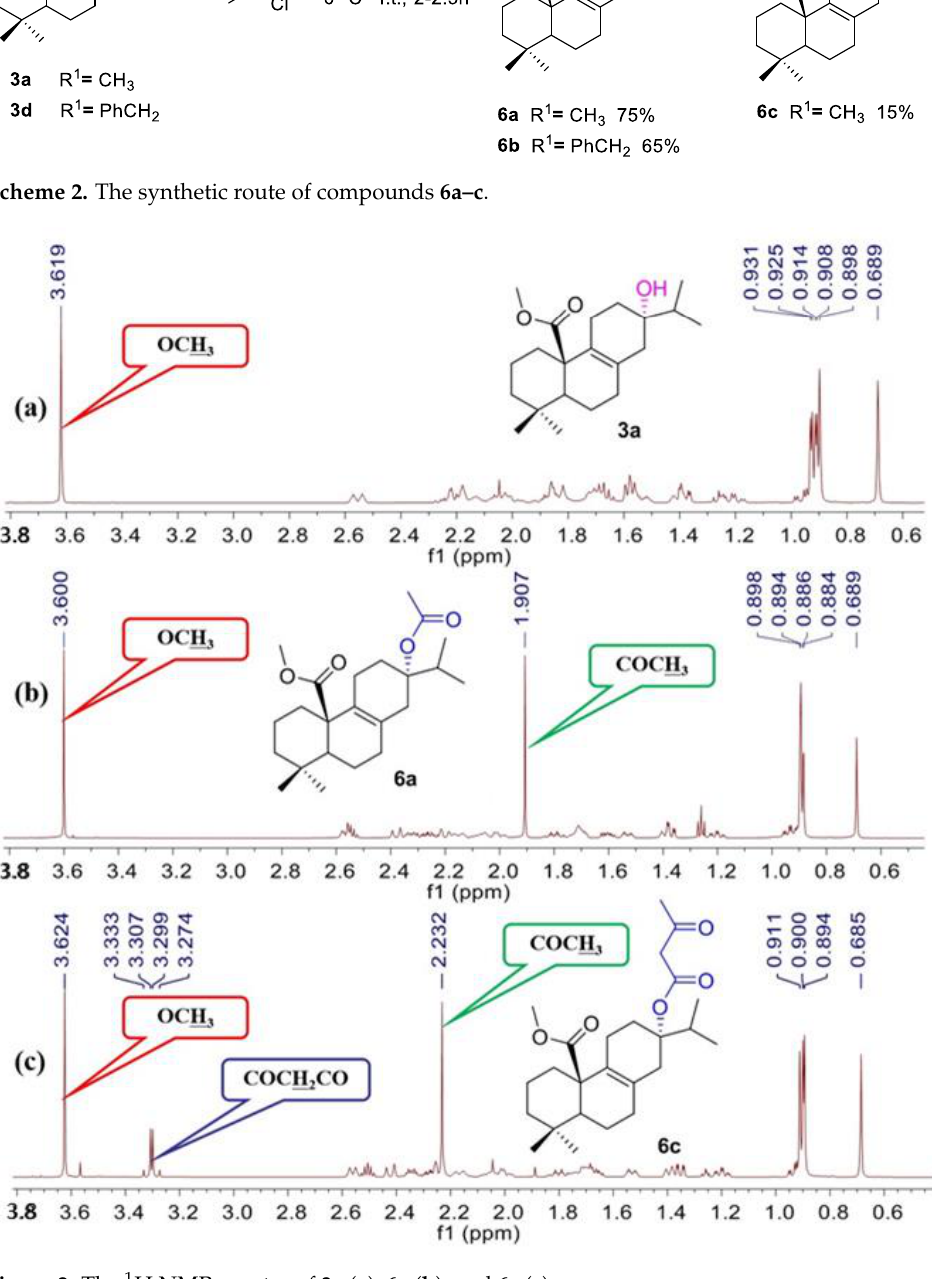
Figure 3. X-ray crystallographic structure of 6a . 2.2. In Vitro Antifungal Activity Evaluation against Filamentous Fungi and Yeasts The antifungal activities of lophanic acid derivatives ( 3a – 6c ) were investigated against two filamentous fungi ( T. rubrum , T. mentagrophytes ) and two yeasts ( C. neoformans, C. albicans ) in vitro at 100 μg/mL with miconazole served as a positive control age nt. As shown in Table 1, compounds 3d and 3i exhibited a broad spectrum of antifungal activities against T. rubrum, T. mentagrophytes, and C. neoformans with inhibitory rates over 60%. On the other hand, some compounds were found to exhibit selective activities against filamentous fungi. For example, compound 3a inhibited the growth of T. rubrum by 81.61%, but it showed only a 49.1% inhibitory rate against C. neoformans . Compounds